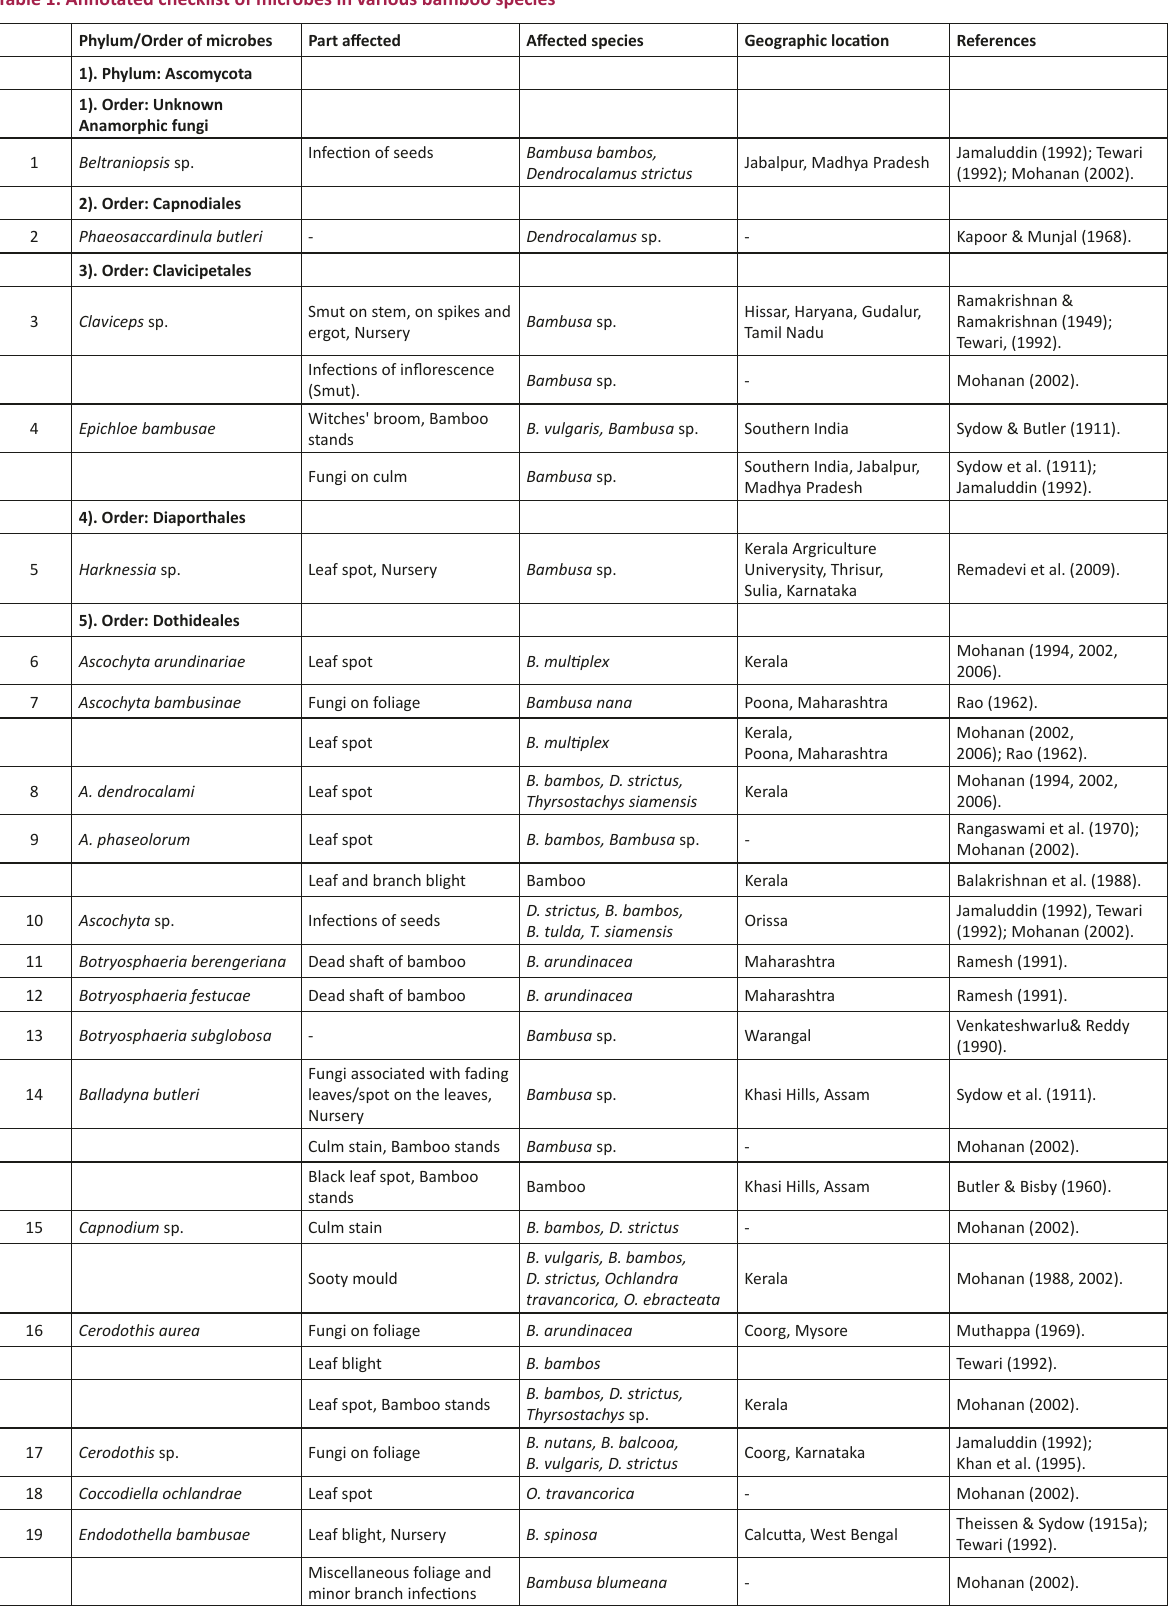
Table 1. Annotated checklist of microbes in various bamboo